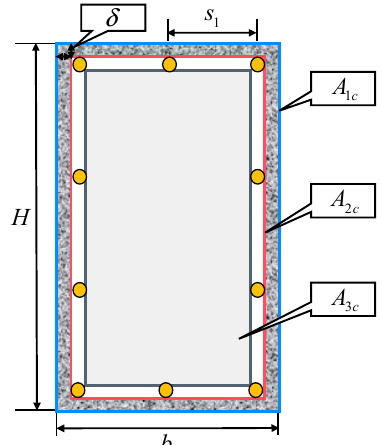
Figure 3. The bearing capacity model of corroded reinforced concrete (RC) column under axial compression. A 1c : cracking area of unconfined concrete; A 2c : cracking area of confined concrete; A 3c , no cracking area of confined concrete; A 1,red : the longitudinal reinforcement area considering the buckling effect; H and b : the height and width of the rectangular column, respectively; s 1 : the lateral spacing of longitudinal reinforcement; δ : the thickness of the concrete